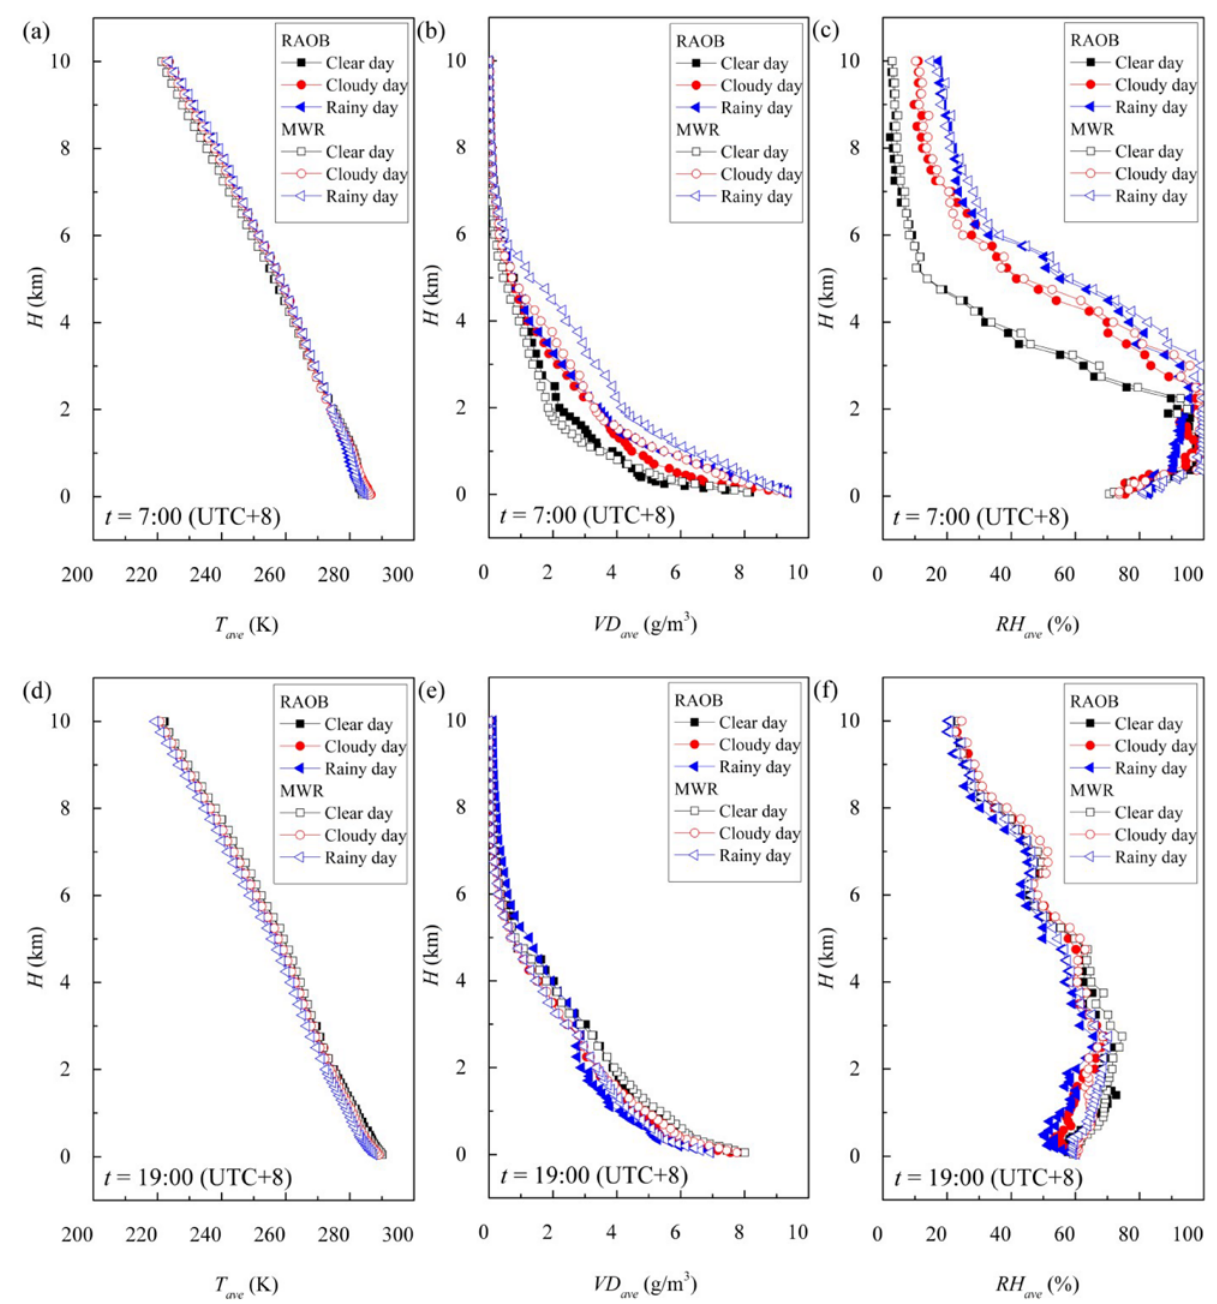
Figure 3. Comparison of temperature ( a , d ), vapor density ( b , e ), and relative humidity ( c , f ) profiles obtained from MWR and radiosonde observations under clear-sky, cloudy-sky, and rainy-sky conditions. Panels ( a – c ) and ( d – f ) denote retrieval parameters at 7:00 and 19:00, respectively.